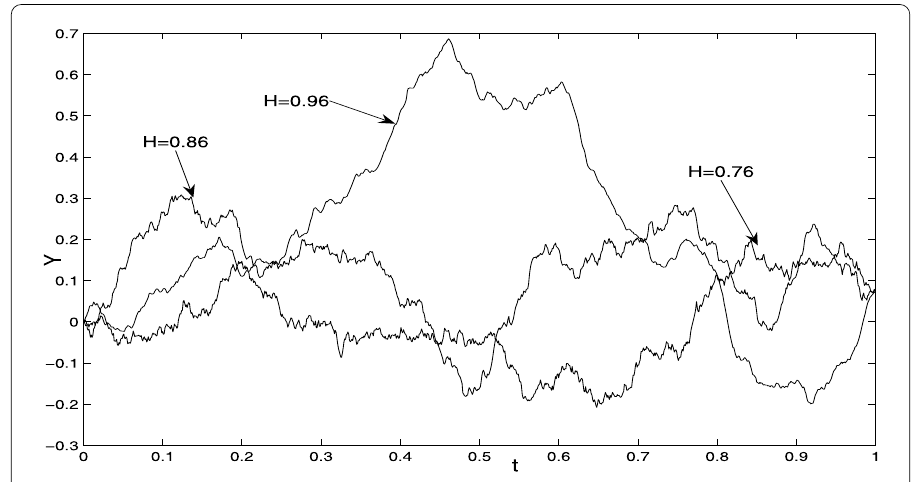
Figure 1 Sample paths of model (9) for different values of Hurst parameter (Chosen parameters a = 0.10; b = –0.2; c =